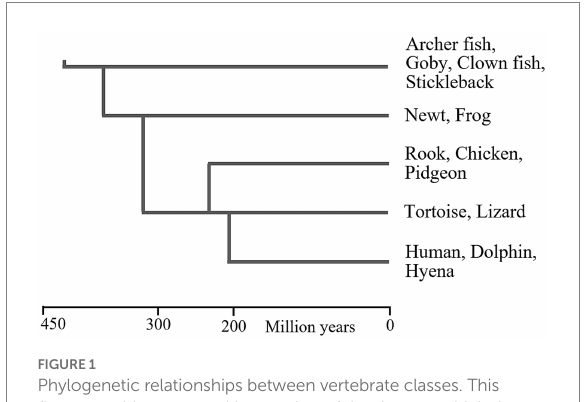
FIGURE 1 Phylogenetic relationships between vertebrate classes. This figure provides a general impression of the dates at which these animal classes first evolved. There are various problems- associated with fossil identification and molecular clocks-that can result in large differences between reported dates (Cunningham et al., 2016). Approximate dates of the LCA of pairs vertebrate classes (shown as vertical lines) were extracted from figures in Laurin and Reisz (1995), Kemp (2005), Alcober, et al. (2010), Godefroit et al. (2013), Nesbitt et al. (2013), Marsicano, et al. (2016), Zhao et al.